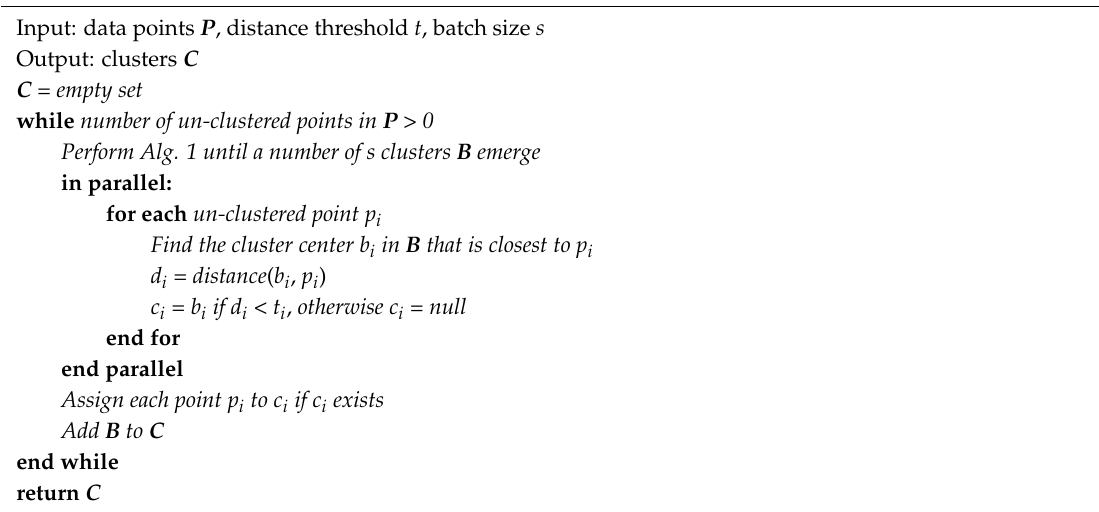
Algorithm 2: Parallel Incremental